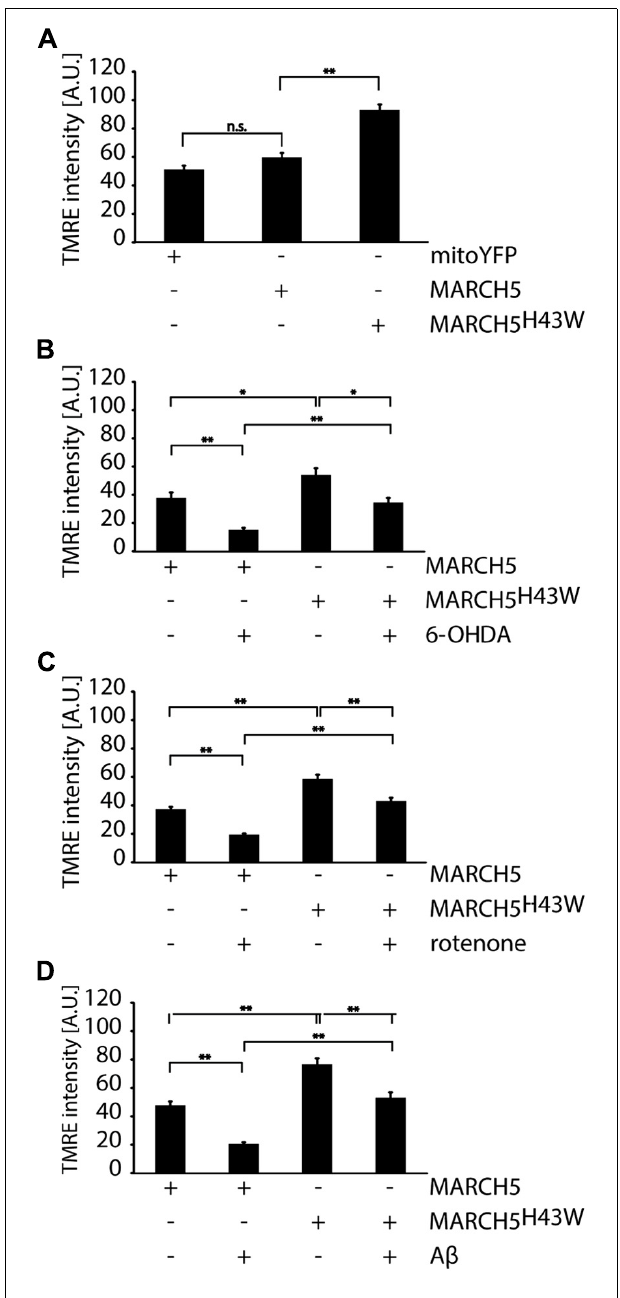
FIGURE 4 | Mitochondrial membrane potential under neurodegenerative stress conditions is increased following inactivation of MARCH5 . (A) SH-SY5Y cells expressing mitoYFP, MARCH5-YFP, or MARCH5 H43W -YFP were stained with the mitochondrial membrane potential sensitive dyeTMRE, images were taken by confocal microscopy andTMRE fluorescence as measure for mitochondrial membrane potential was determined using image analysis. SH-SY5Y cells expressing MARCH5-YFP or MARCH5 H43W -YFP were treated with 75 μ M 6-hydroxydopamine for 6 h (B) , 5 μ M rotenone for 6 h (C) , or 25 μ M A β peptide for 24 h (D) and mitochondrial membrane potential was measured as in (A) . Shown is the average of three independent experiments with 10 cells each per condition. Statistical significance was analyzed using Student’s t -test with * p <0.05; n.s. p >0.05, not significant and ** marking p < 0.01. Error bars represent